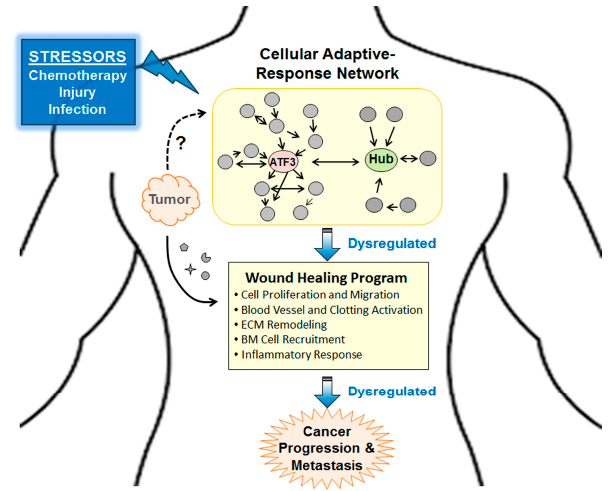
Figure 3. A schematic for the “dysregulated adaptive-response hypothesis.” Briefly, dysregulation of cellular adaptive-response network plays a central role for seemingly different stressors, such as chemotherapy, tissue injuries, and tumor signals to enhance cancer progression and metastasis. The “wound healing program” denotes a generic program entailing the indicated processes (in bullet points). However, detailed molecules or genes involved may vary in different context. ECM, extracellular matrix; BM, bone marrow.